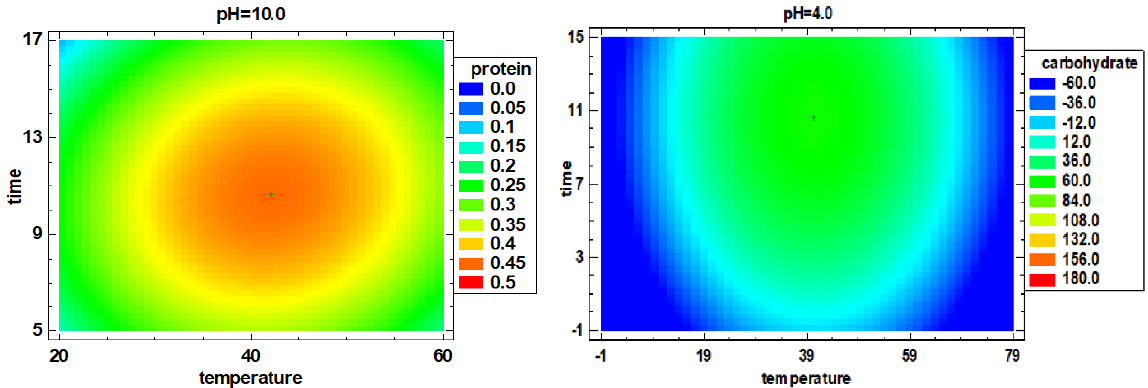
cially after PLE at 5 min and pH 4 either at 20 °C (6.90 mg/g) or 60 °C (8.81 mg/g) ( p < 0.05).